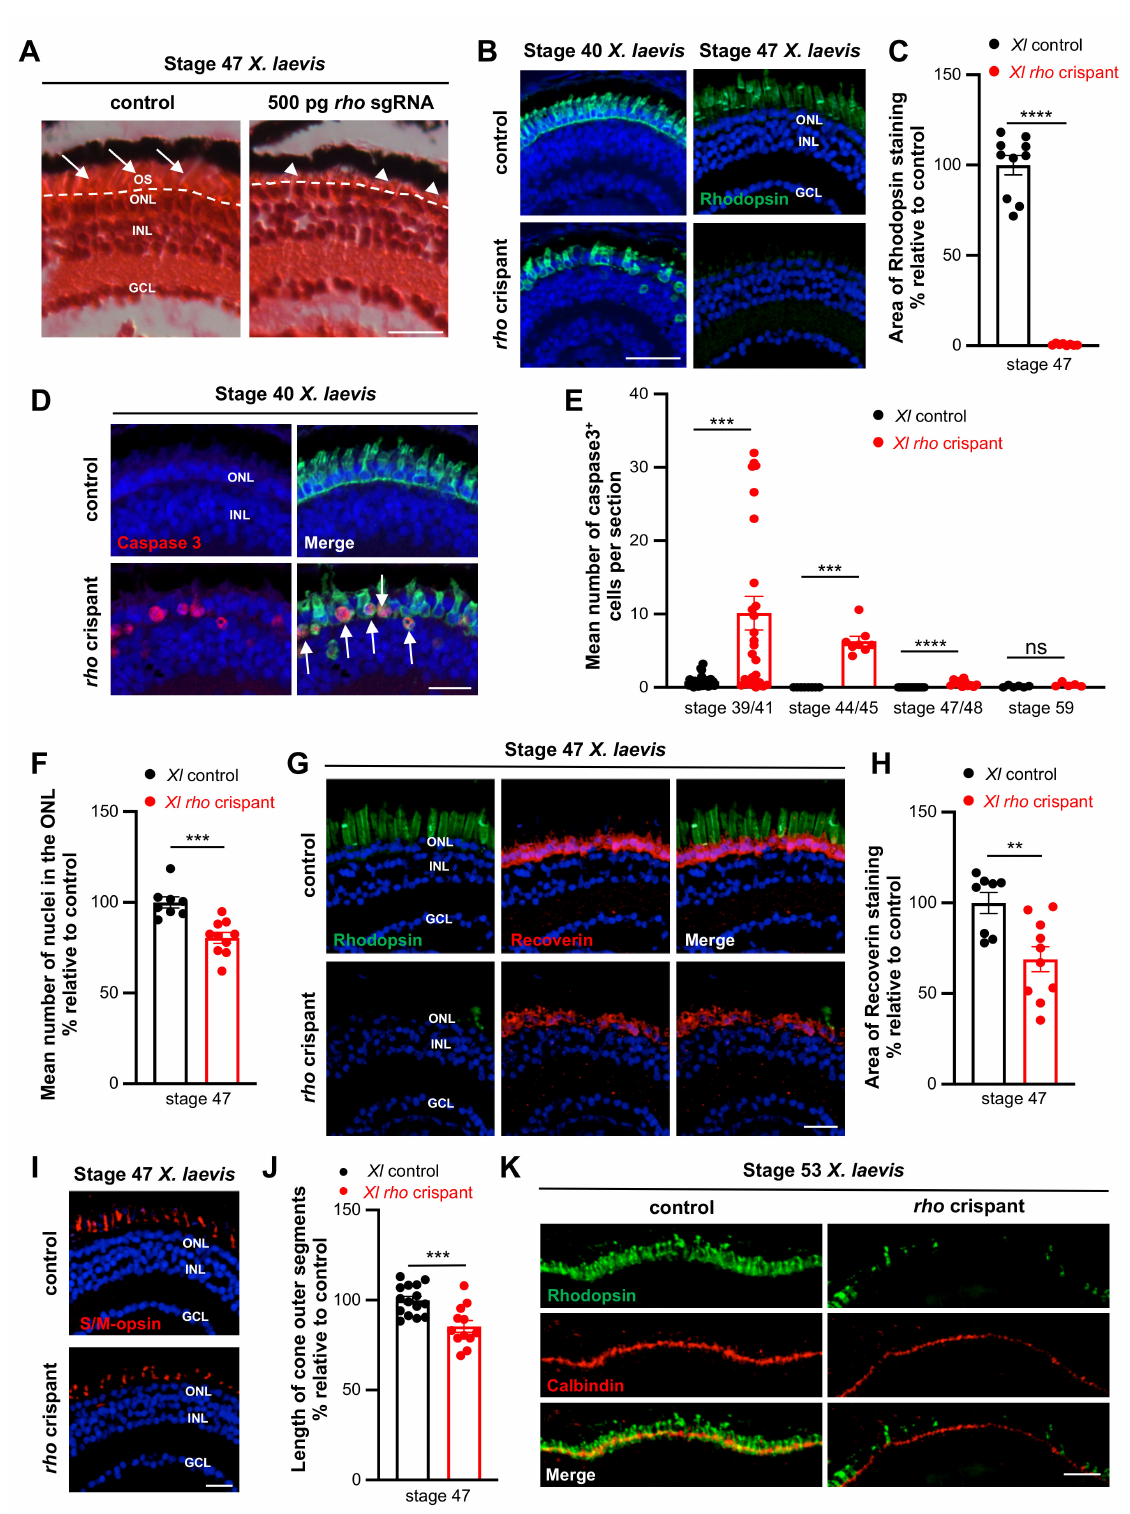
Figure 5. Rod degeneration and cone defects in X. laevis rho crispants. ( A ) Hematoxylin and Eosin staining on retinal sections from stage 47 control and rho crispant X. laevis tadpoles. The dotted line delineates the border between the outer nuclear layer and photoreceptor outer segments (arrows). Arrowheads point to shortened outer segments. ( B , C ) Immunofluorescence analysis of Rhodopsin expression on retinal sections from control and crispant X. laevis tadpoles at stage 40 or 47. The area of Rhodopsin staining at stage 47 is quantified in ( C ). ( D ) Typical retinal sections from